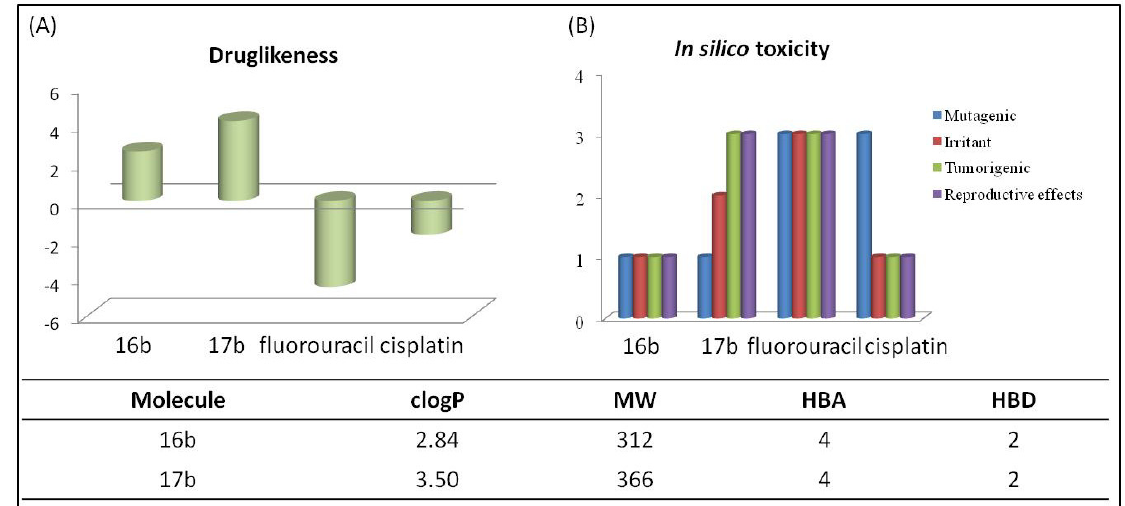
Figure 5. Comparison of 16b and 17b with anticancer marketed drugs, cisplatin and fluorouracil, ( A ) “Druglikeness”; and ( B ) in silico toxicity values calculated by using the Osiris Program and the physico-chemical parameters considering Lipinski’s rule-of-five